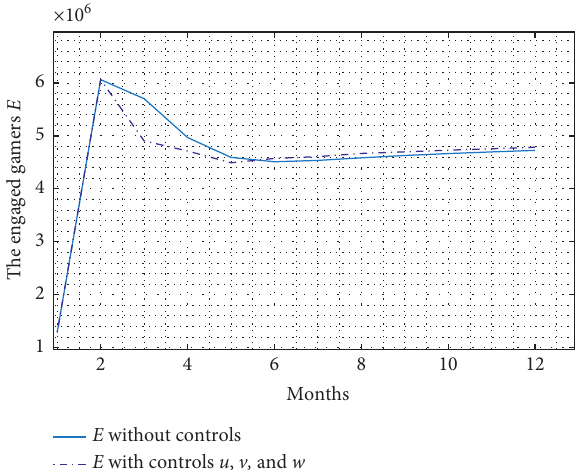
Figure 9: The evolution of the number of the engaged gamers with combination of the three